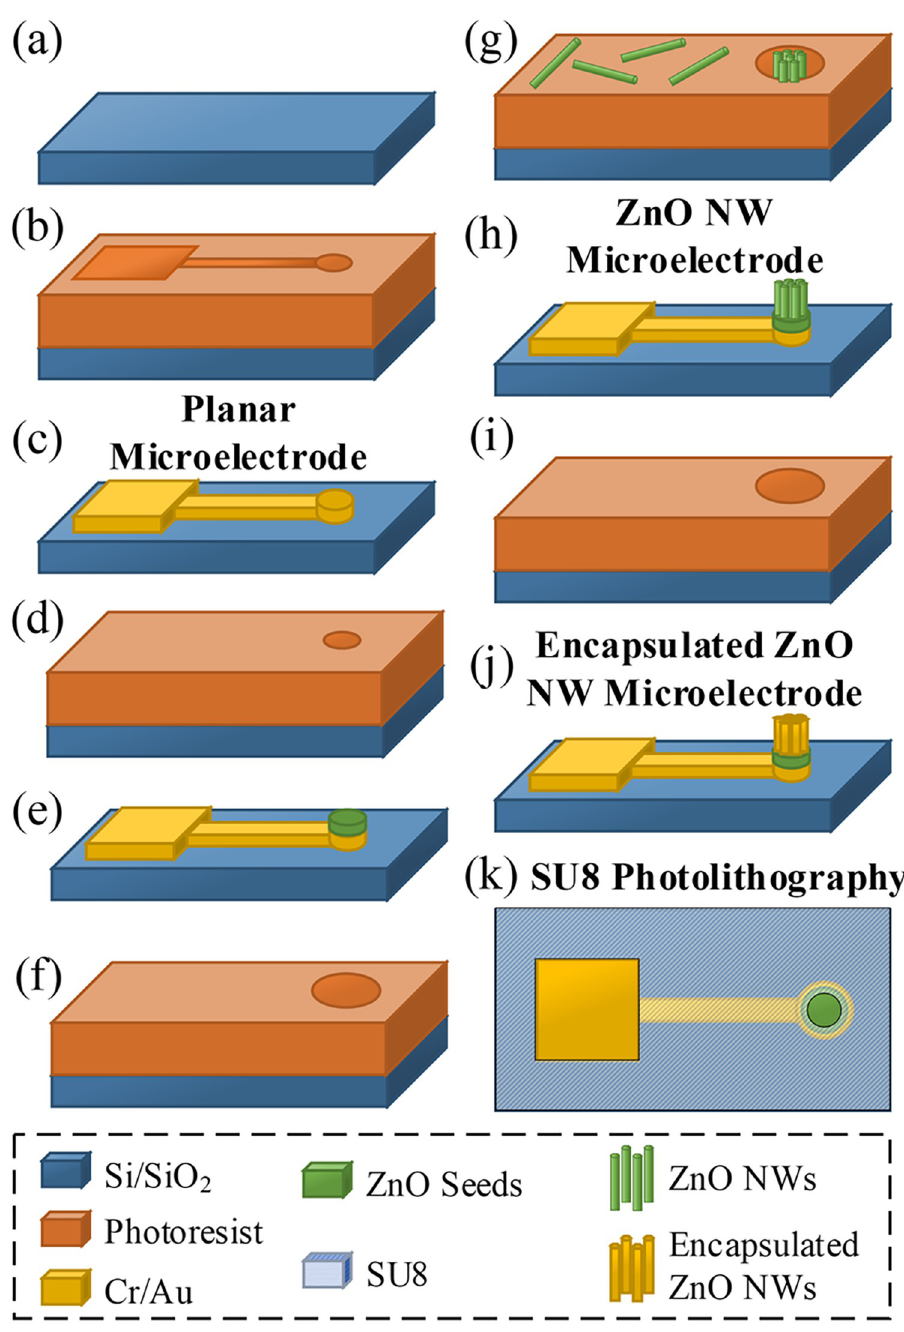
Fig 2. The fabrication process of the planar microelectrode, pristine ZnO NW microelectrode and metal encapsulated ZnO NW microelectrodes. (a) Si/SiO 2 substrate preparation; (b) photolithography; (c) deposition of Cr/ Au layer by thermal evaporation followed by lift-off, resulting in a planar microelectrode; (d) photolithography; (e) Sputter deposition of a ZnO seed layer followed by lift-off; (f) photolithography; (g) hydrothermal growth of ZnO nanowires; (h) lift-off to remove ZnO nanowire debris, resulting in a ZnO NW microelectrode; (i) photolithography; (j) deposition of a metallic encapsulation layer by thermal or e-beam evaporation followed by lift-off, resulting in a metal encapsulated ZnO NW microelectrode. The fabrication of all microelectrodes was completed by SU8 photolithography, as shown from the top-view in (k), which deposited a SU8 passivation layer to cover the entire substrate surface except the regions above the working microelectrodes and outer electrodes for electrical